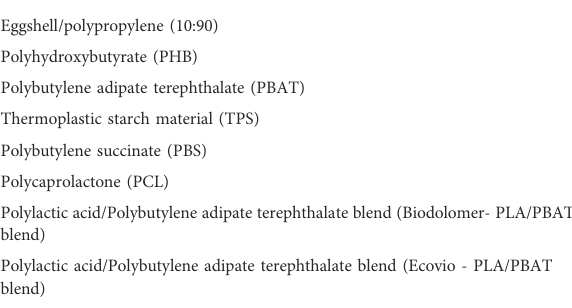
TABLE 6 Bio-based polymer samples which showed no cytotoxic activity in the MTT assay or (ant)agonist hormonal activity in the MMV-Luc (estrogen responsive), TARM- Luc (androgen responsive) or TM-Luc (progestogen responsive) RGA cell lines at any of the standardised testing